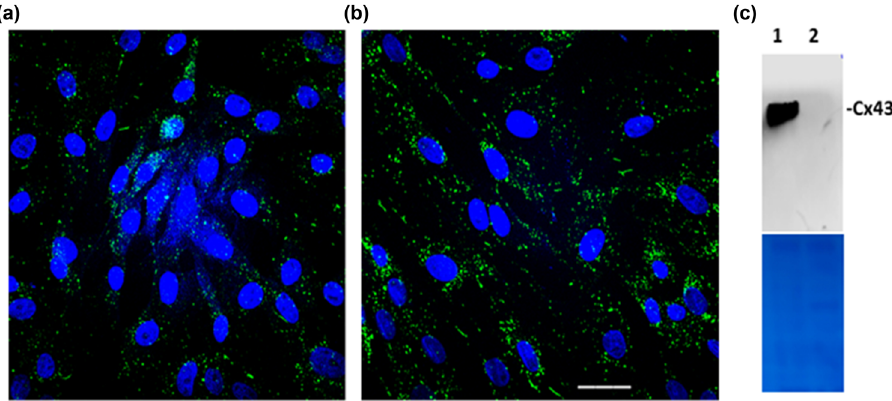
Figure 1: Upregulation of Cx43 expression in HUVECs under stretch. ( a ) Cx43 expression ( green ) in HUVECs with nonstretch. ( b ) Cx43 expression in HUVECs with 24 h stretch. Scale bar = 20 µm. ( c ) Validation of anti - Cx43 speci fi city in HeLa cells by western blotting. ( 1 ) HeLa cells were transfected with a Cx43 expression vector ( Cx43 - pcDNA3.1 ) . ( 2 ) HeLa cells were transfected with an empty vector ( pcDNA3.1 ) . Coomassie blue staining was used as a protein loading